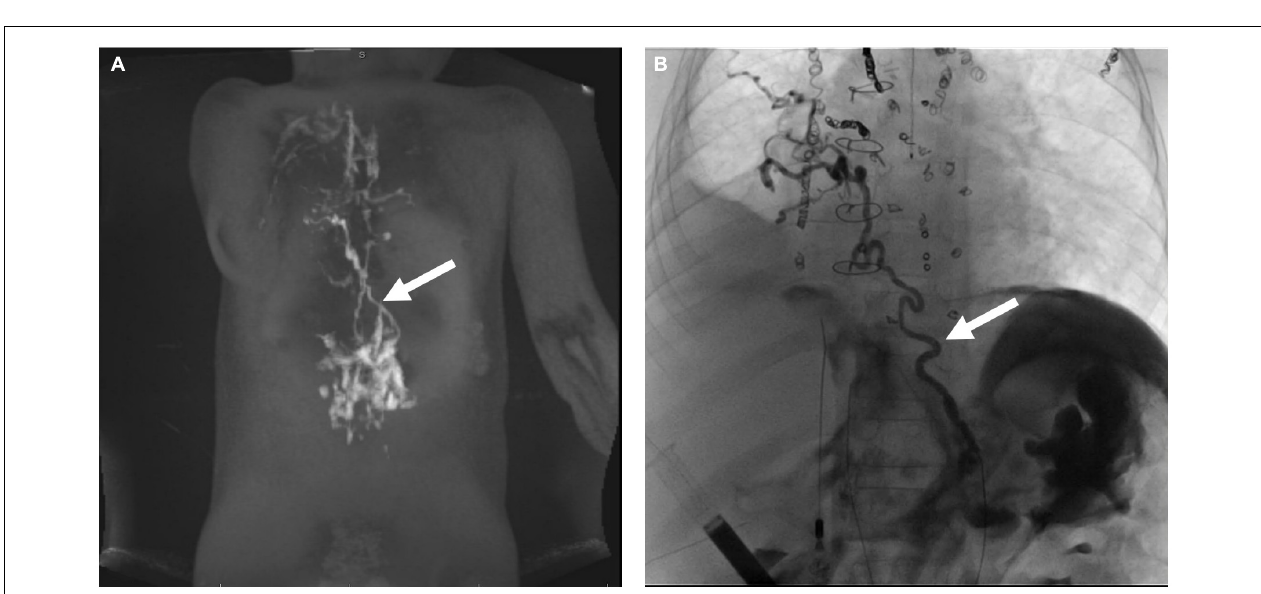
FIGURE 6 | PB treatment pathway (TD-thoracic duct, DCMRL-dynamic contrast lymphangiography, IN-intranodal, IH-intrahepatic, SLDE-selective lymphatic duct embolization, TDL-thoracic duct ligation, TDE-thoracic duct embolization, TDD-thoracic duct decompression, LVA-lymphovenous anastomosis, PLPS-pulmonary lymphatic perfusion